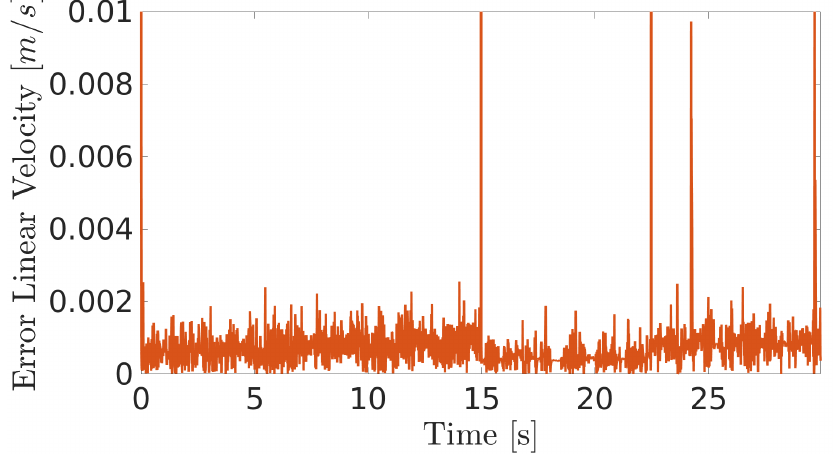
Figure 10. Linear velocity error during navigation of the climbing robot in the storage tank.